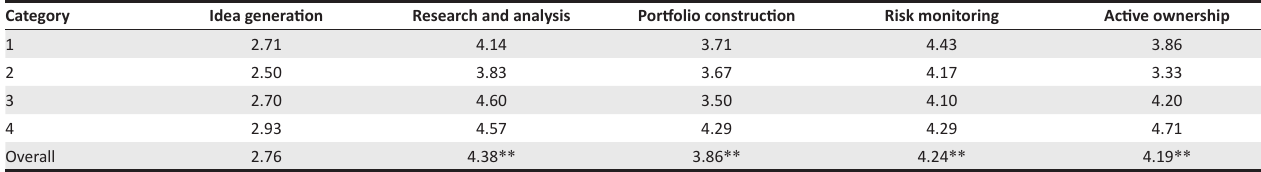
TABLE 7: Relevance of environmental, social and governance considerations in the investment process. Category